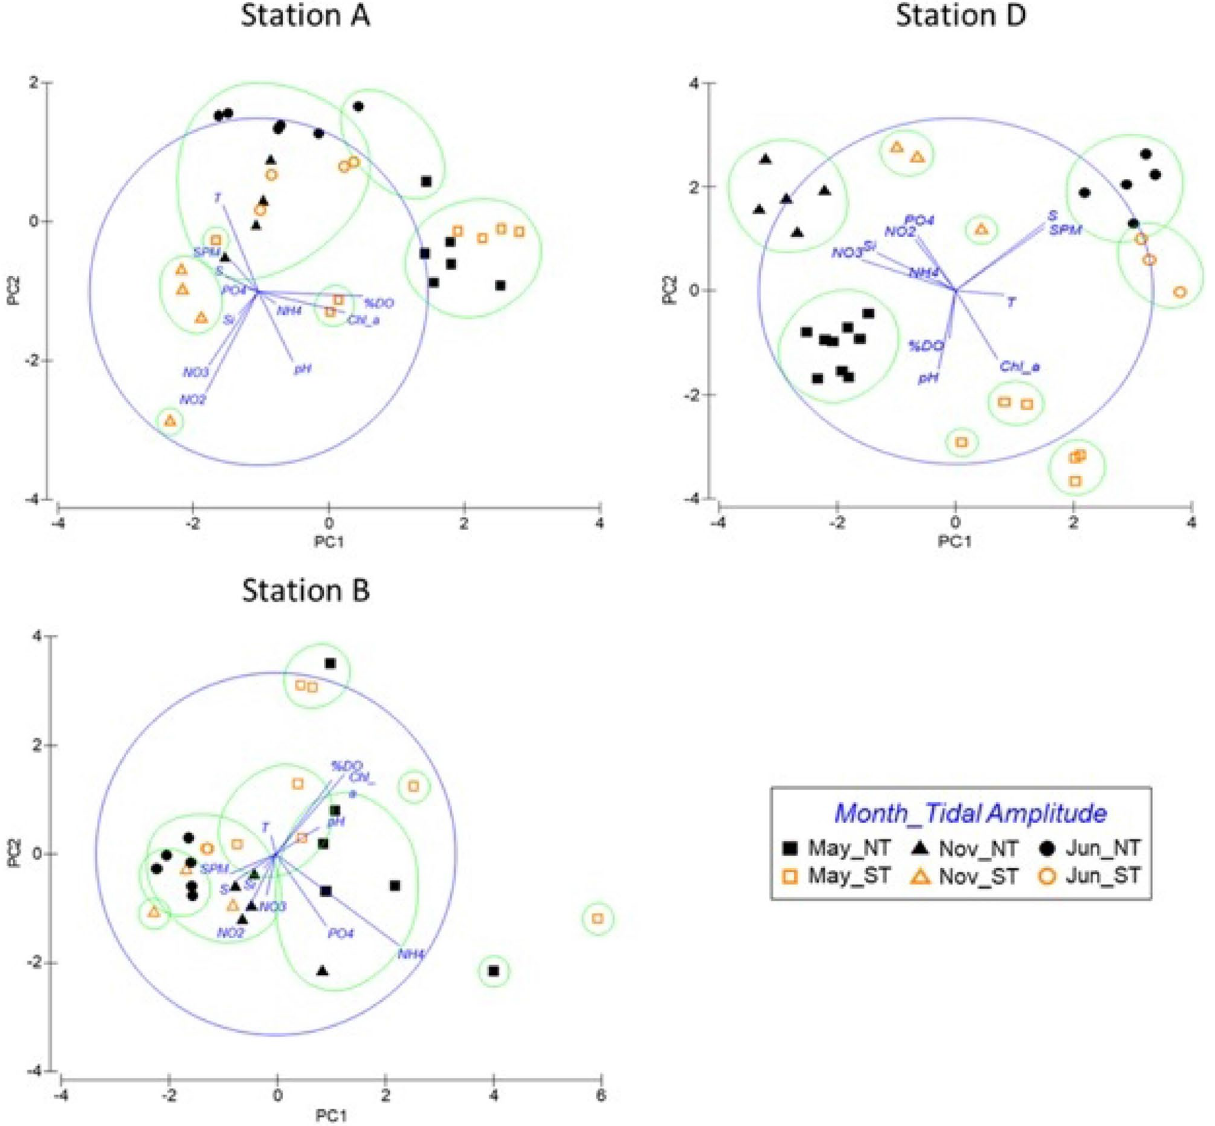
Figure 5. Principal component analysis (PCA) considering the data collected in the sampling stations A, B and D. Samples classified according to the month of the data collection (May/18, Nov/18 and Jun/19) and the respective tidal amplitude (NT and ST). T temperature, S salinity, %DO dissolved oxygen, SPM suspended particulate matter, Chl_a chlorophyll a and Si silicate Si(OH) 4 . The figure was produced using PRIMER 6 (6.1.16) + PERMANOVA (1.0.6) software from PRIMER-e (https:// www. primer- e.